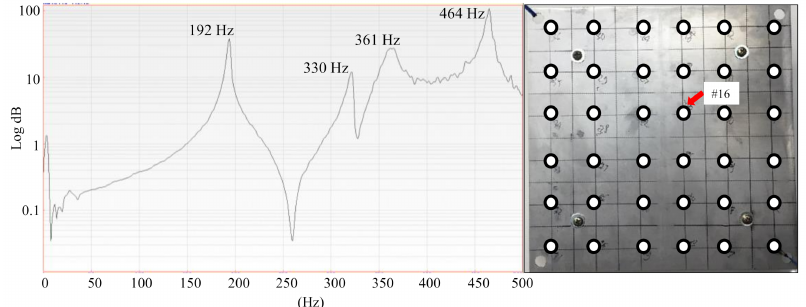
Figure 11. Frequency response function (FRF) of the healthy fully-assembled TPS panel at measurement point